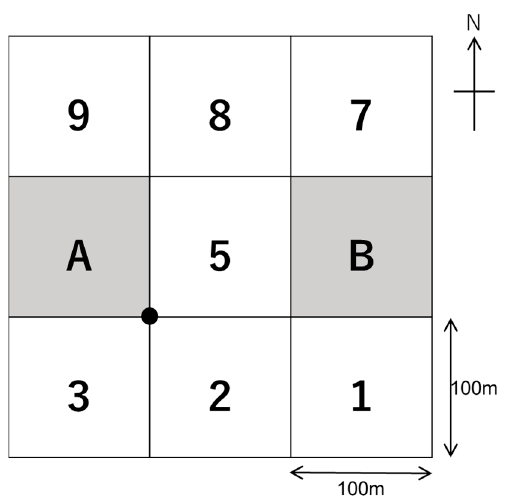
Figure 2. Layout of the nine 1-ha subplots in Compartment 93, South Zamaye Reserved Forest, Bago Yoma, Myanmar. The south-east corner of subplot A (black dot) was the starting point for establishing the plot.